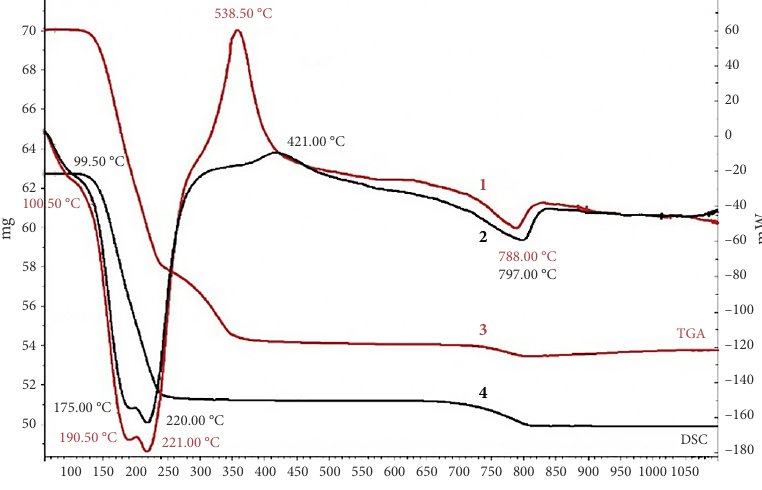
Figure 5. Differential scanning calorimetry spectra: the check sample (2, 4), the sample with 7.5% of modified technical sulfur (1,